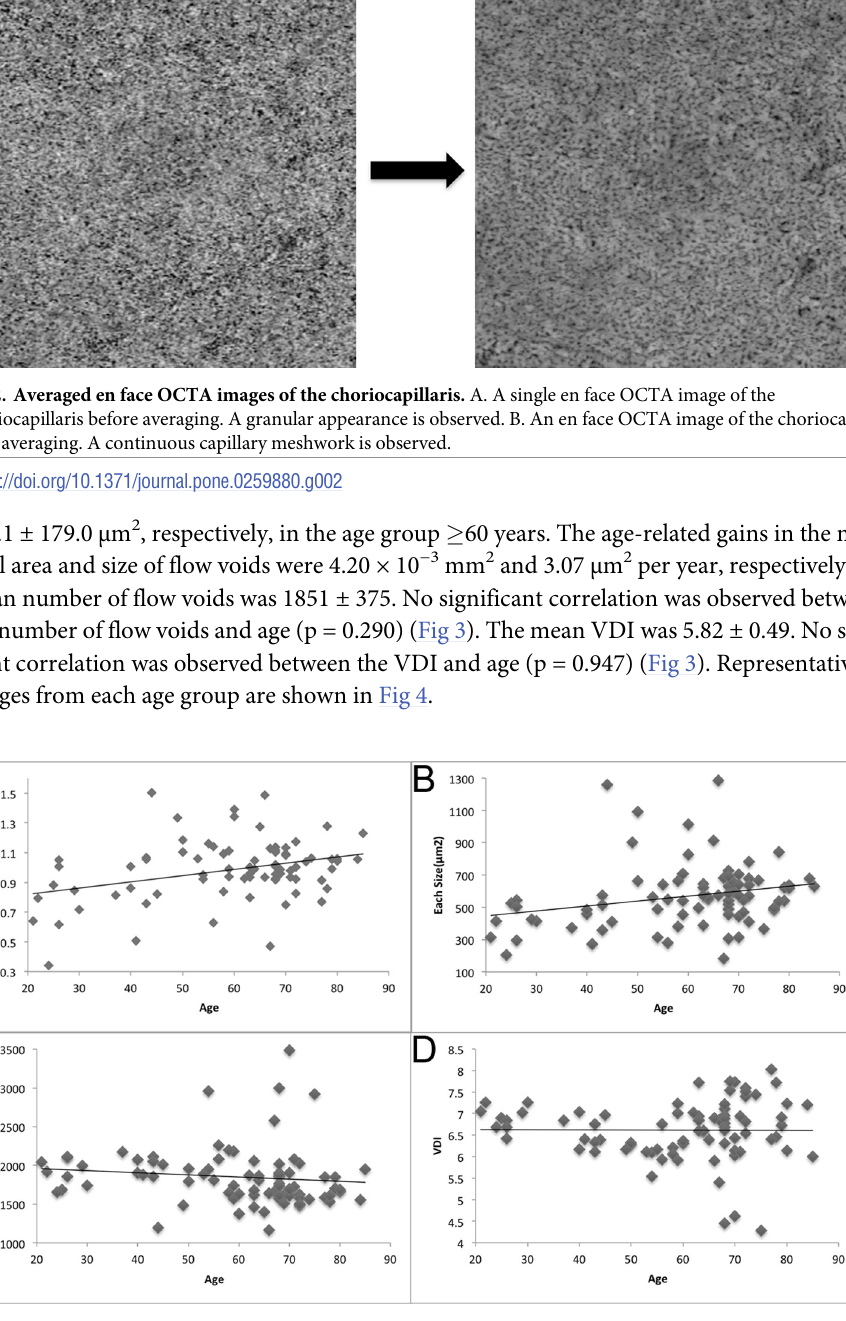
Fig 3. Correlations among age, total area, size, and number of flow voids, and the VDI. A. Correlation between the total area of flow voids and age. The mean total area is 0.99 ± 0.20 mm 2 . The total area positively correlates with age (p = 0.002, R = 0.336). B. Correlation between the size of flow voids and age. The mean size of flow voids is 567.8 ± 201.5 μ m 2 . The size of flow voids positively correlates with age (p = 0.026, R = 0.247). C. Correlation between the number of flow voids and age. The mean number of flow voids is 1851 ± 375. No significant correlation is observed between the number of flow voids and age (p = 0.290). D. Correlation between the VDI of the flow voids and age. The mean VDI is 5.82 ± 0.49. No significant correlation is observed between the VDI and age (p = 0.947).